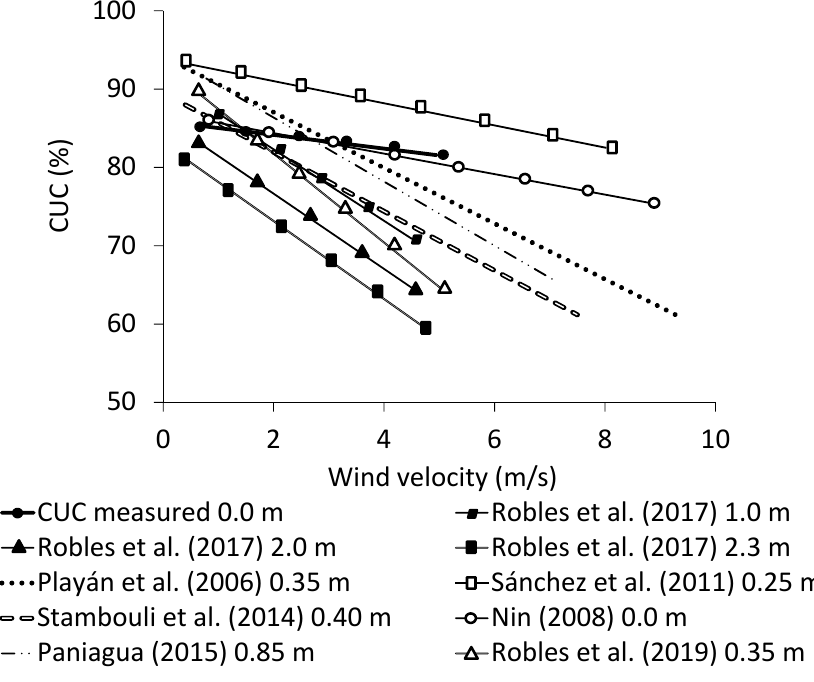
Figure 10. Experimental CUC related with the wind velocity at different catch can heights for dif- ferent research works. Figure 10 also includes the 61 experiments of Nin [33] on impact sprinklers at pres- sures from 220 kPa to 450 kPa, performed with the sprinkler height at 2.0 m and the catch can located at the soil level. The 60 experiments performed in this study are also shown